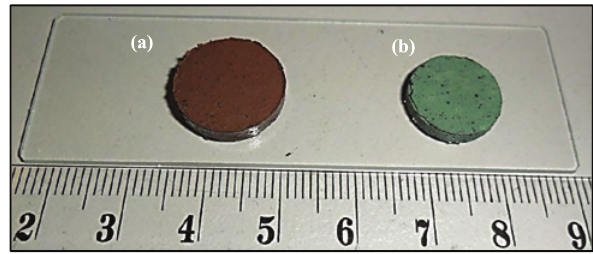
Fig. 7: Cylindrical pellet of manganese oxide: (a) before reduction (Mn 3 O 4 ) and (b) after reduction (MnO) with